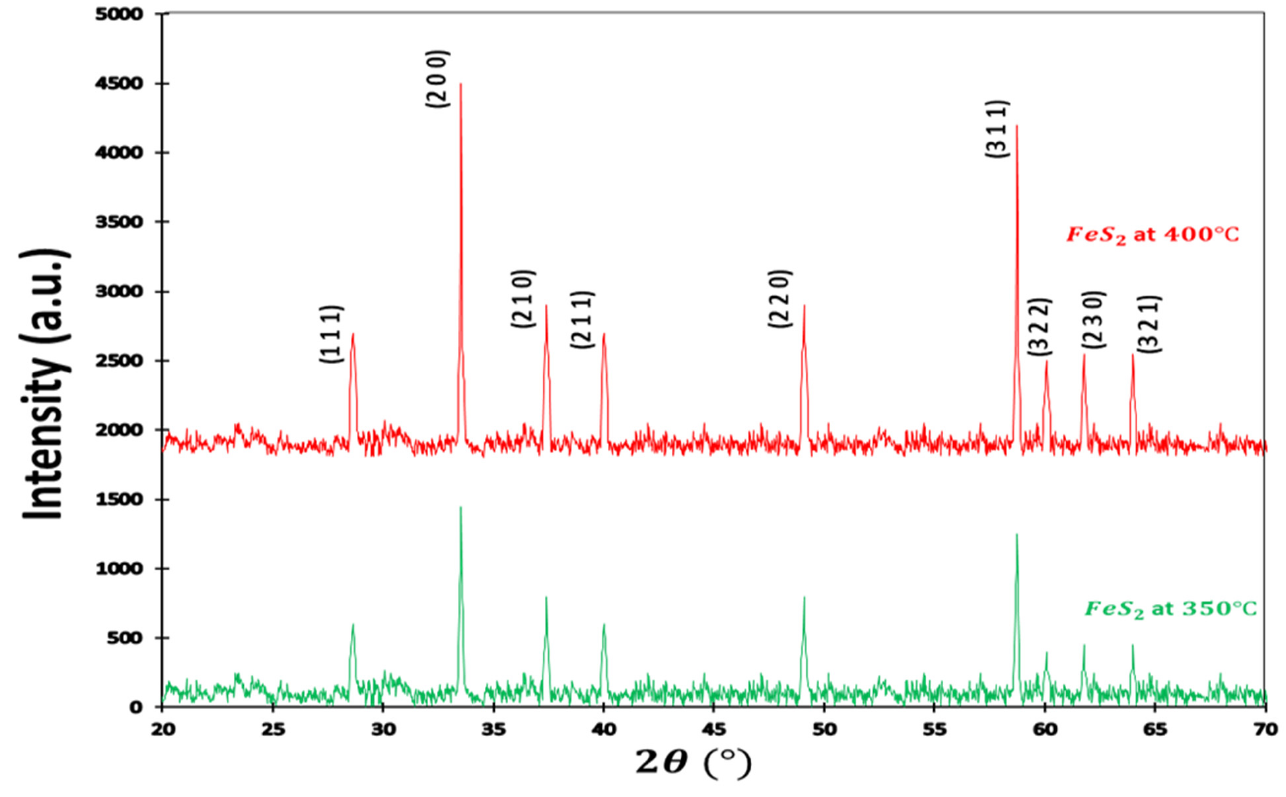
Figure 1. XRD pattern of FeS 2 pyrite. The output parameters are listed in Table 1.